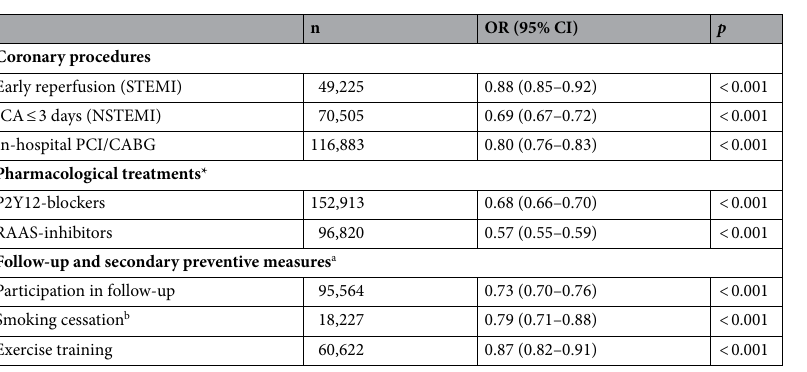
Table 2. Utilization of medical interventions in high-risk patients. Odds ratios refer to comparisons of high- risk patients with low- and intermediate-risk patients, considered as one group. Analysis adjusted for hospital, admission year, sex, current smoking, diabetes, congestive heart failure, previous myocardial infarction, previous percutaneous coronary intervention/coronary artery bypass grafting, previous stroke, atrial fibrillation upon admission, chronic obstructive pulmonary disease, previous or present cancer, peripheral vascular disease, coronary findings (in-hospital PCI/CABG only) and in-hospital PCI/CABG (P2Y12-blockers only). OR odds ratio, CI confidence interval, STEMI ST-elevation myocardial infarction, ICA invasive coronary angiography, NSTEMI non-ST-elevation myocardial infarction, PCI percutaneous coronary